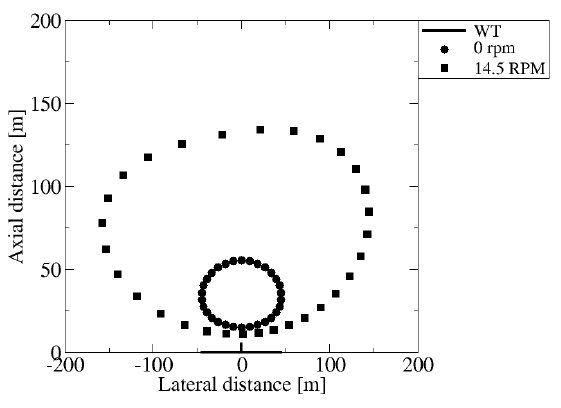
Figure 5. Impact positions for rotating and parked wind turbine.